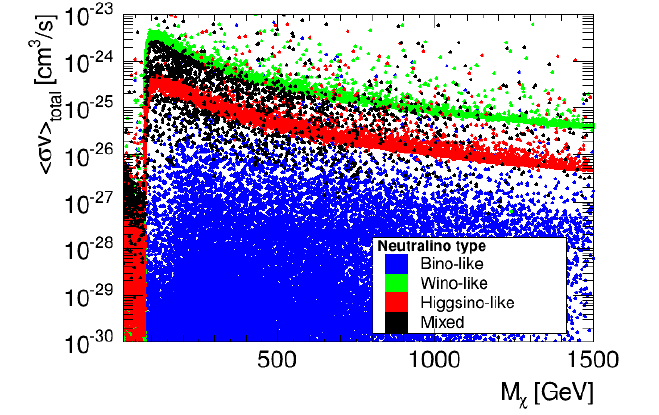
Figure 7 . Total annihilation cross section as a function of the neutralino 1 mass for the di(cid:11)erent neutralino